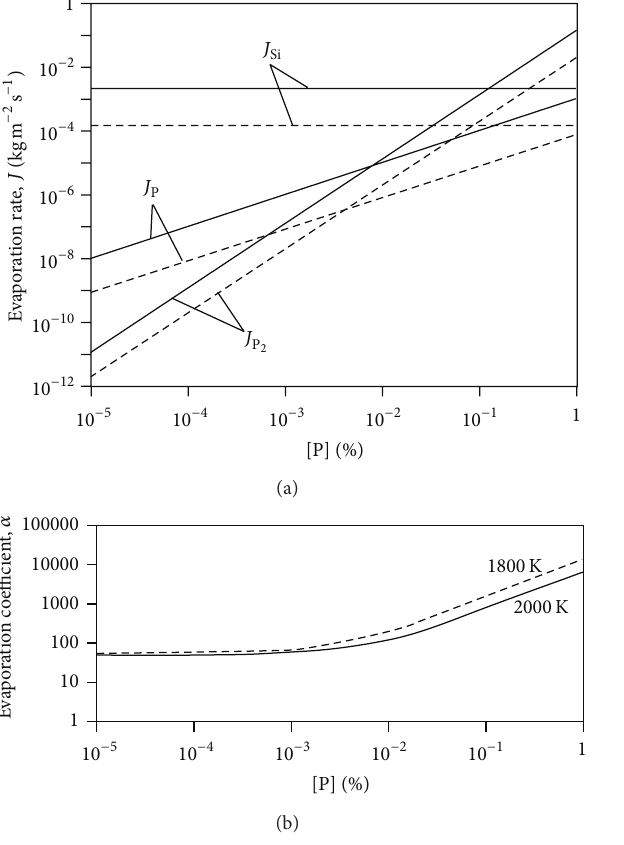
Figure 4: (a) Evaporation rate of P and Si from molten Si at 1800 (broken line) and 2000 K (solid line). (b) Evaporation